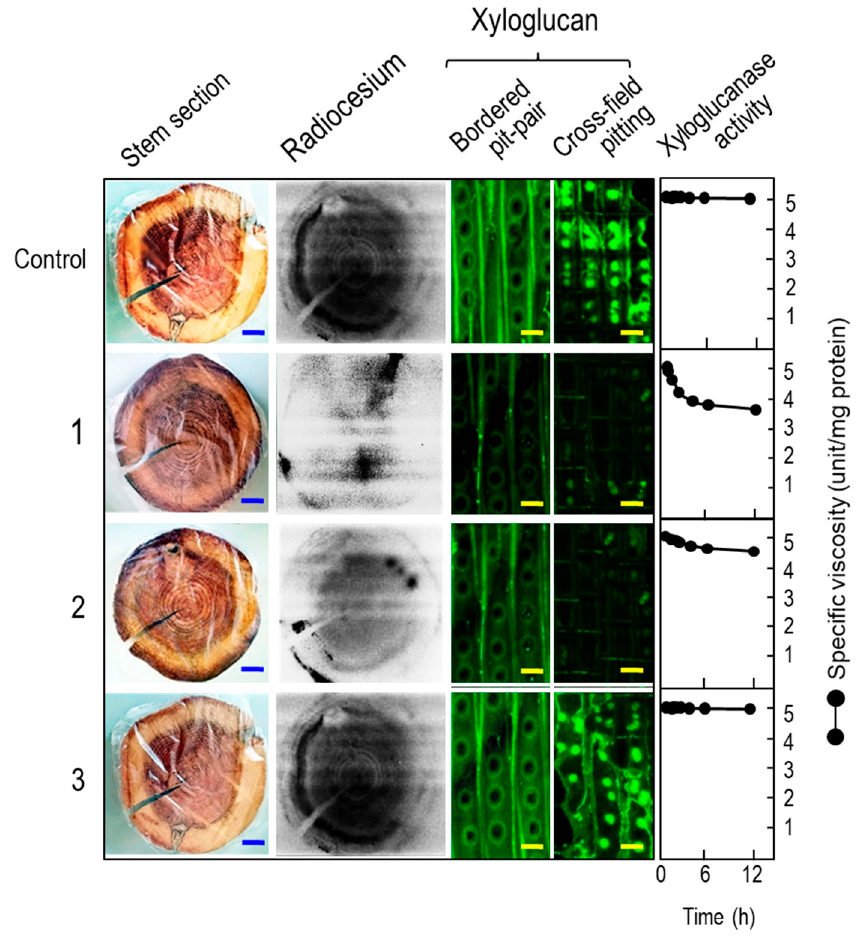
Figure 3. Ponding experiments for the stems of Japanese cedar from Fukushima forest. Analysis of the bottom edge of 165-day ponded stems that were drained by standing them vertically (dotted box in Figure 1). Bordered pit-pair and cross-field pitting were stained as xyloglucan with anti-xyloglucan antibody. Autoradiographies were taken from the insides of the cut surfaces. Xyloglucanase activity was determined by a decrease in the viscosity of tamarind xyloglucan. Scale: blue bar, 6 cm; yellow bar, 20 μ m.